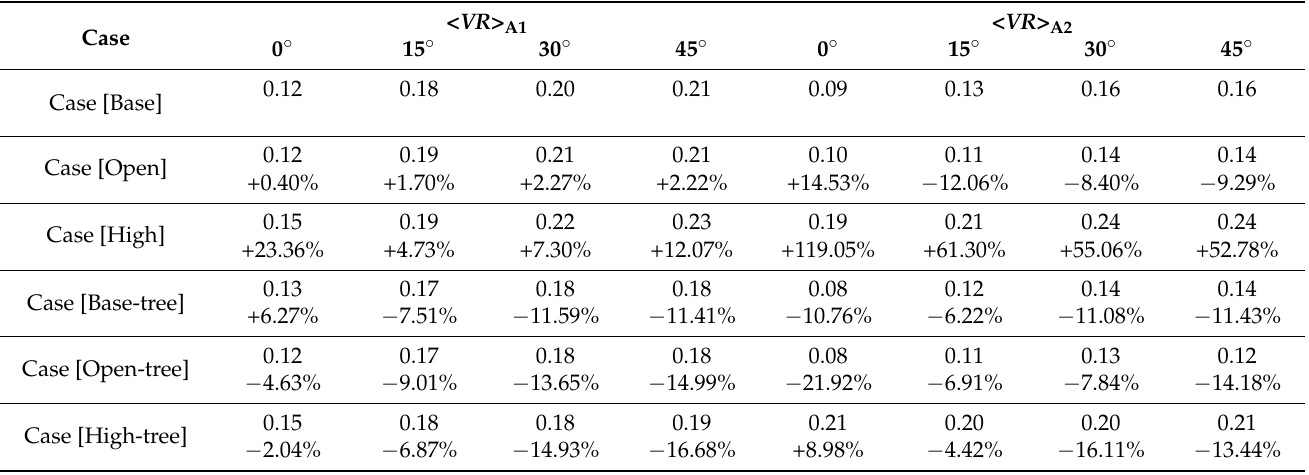
Table A5. Spatial mean velocity ratio ( VR ) at z = 2 m in Region A1 (< VR > A1 ) and Region A2 (< VR > A2 ) of each scenario and the change rate.